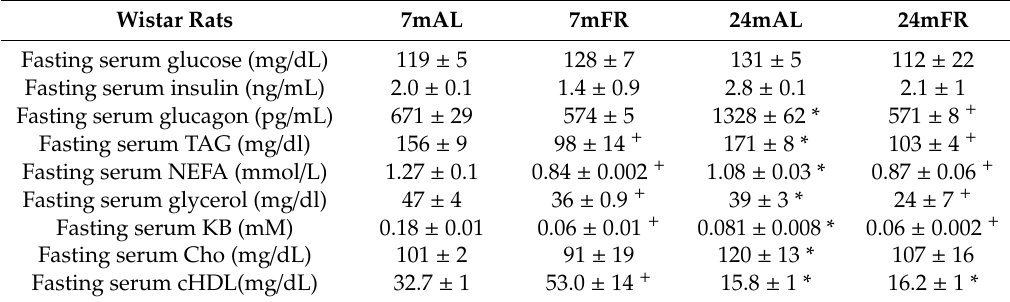
Table 2. Baseline levels of hormones and metabolites before the oral lipid loading test